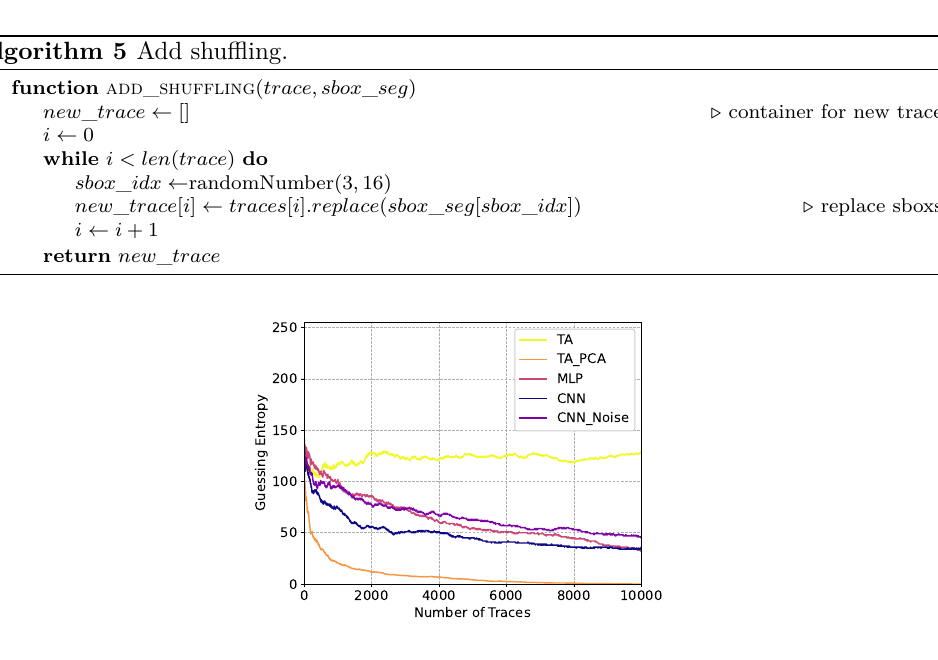
Figure 9: Shuffling: guessing entropy.